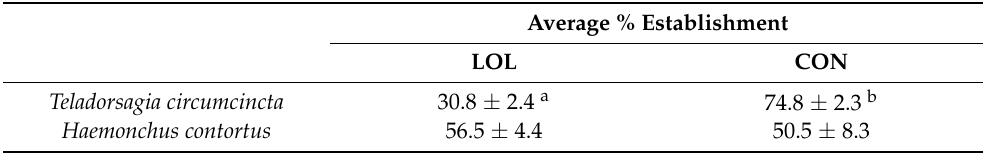
Table 3. In vitro percent establishment of Teladorsagia circumcincta ( n = 2) or Haemonchus contortus ( n = 3) in lambs treated with or without loline.